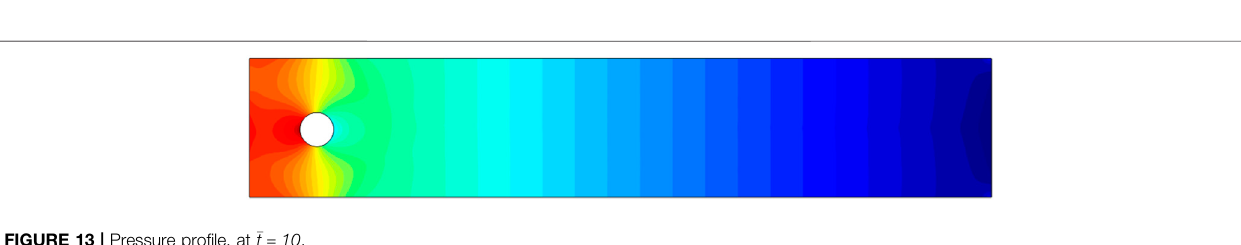
Frontiers in Physics |